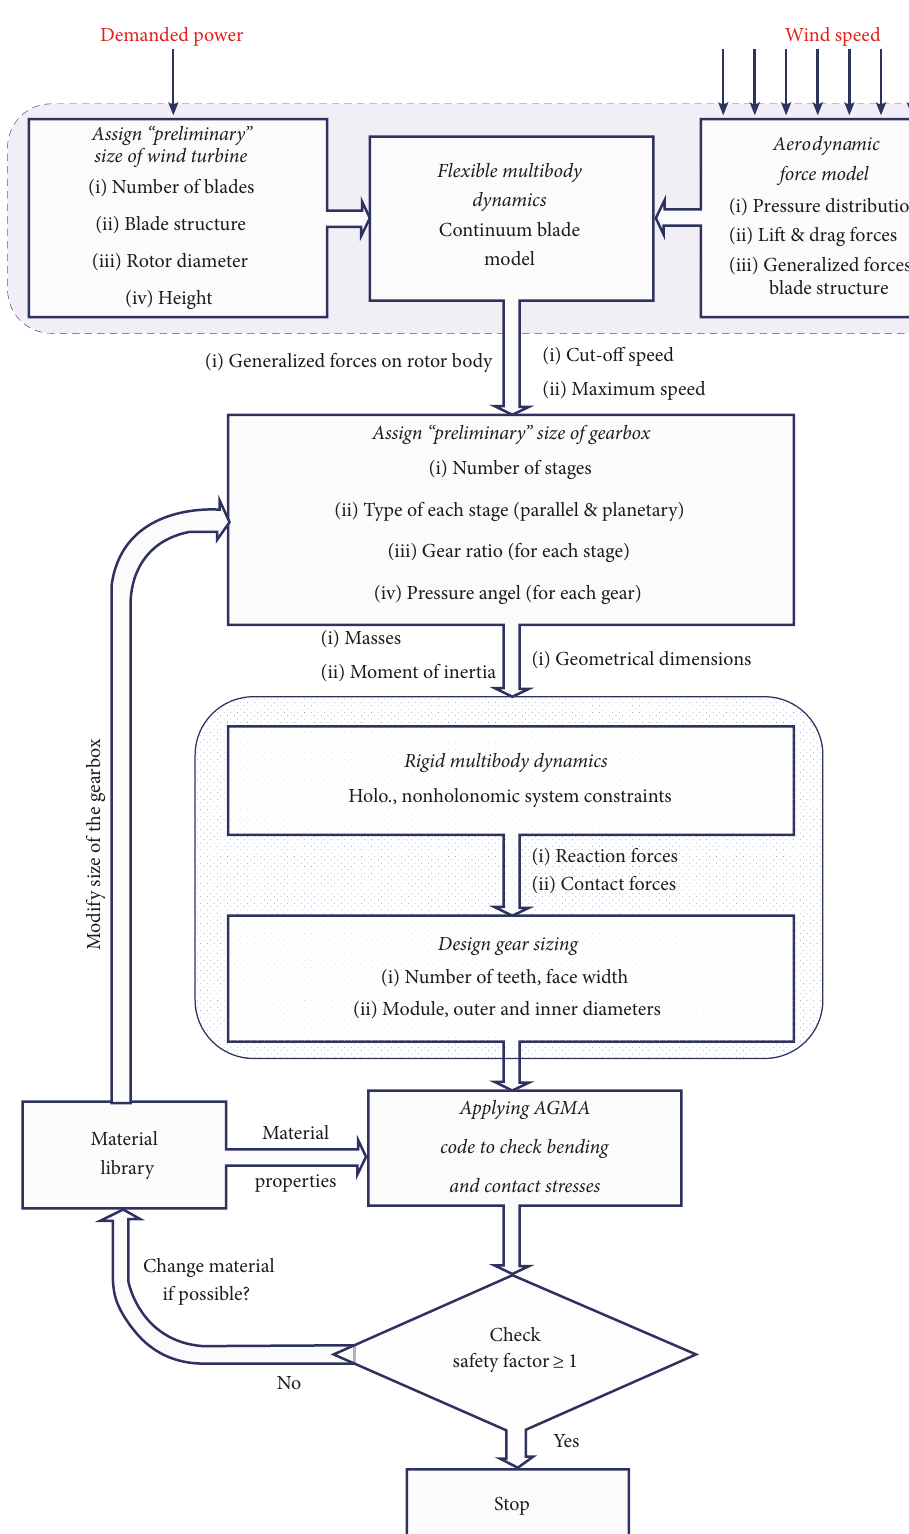
Figure 3: DFD procedure for wind turbine gearbox; the dashed shaded part denotes the blade dynamics module, which is not the focus of this paper, and the solid shaded part denotes the gearbox dynamics module, which is the main issue concerned in this